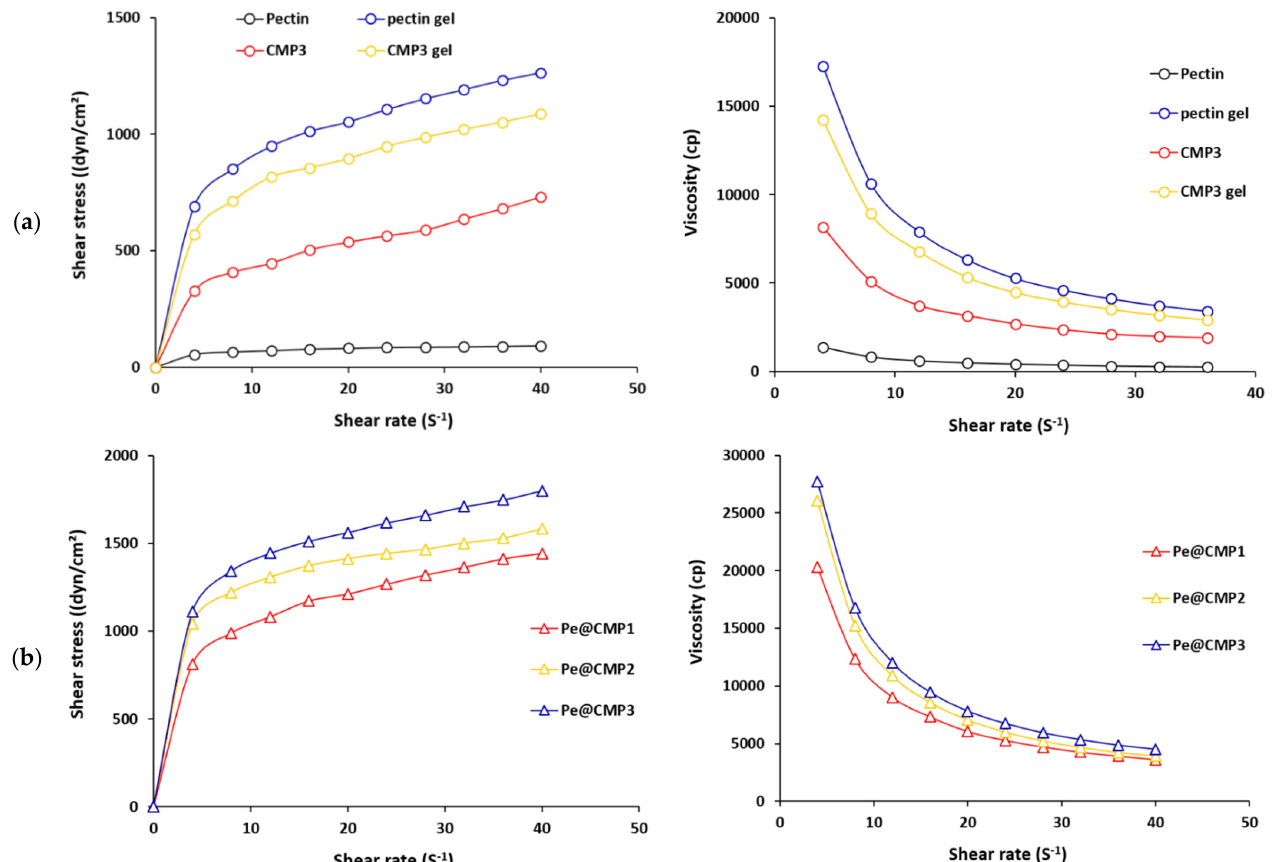
Figure 4. Rheological properties for the pectin, CMP and Pe@CMP hydrogel; ( a ) pectin & CMP and ( b ) Pe@CMP hydrogel.